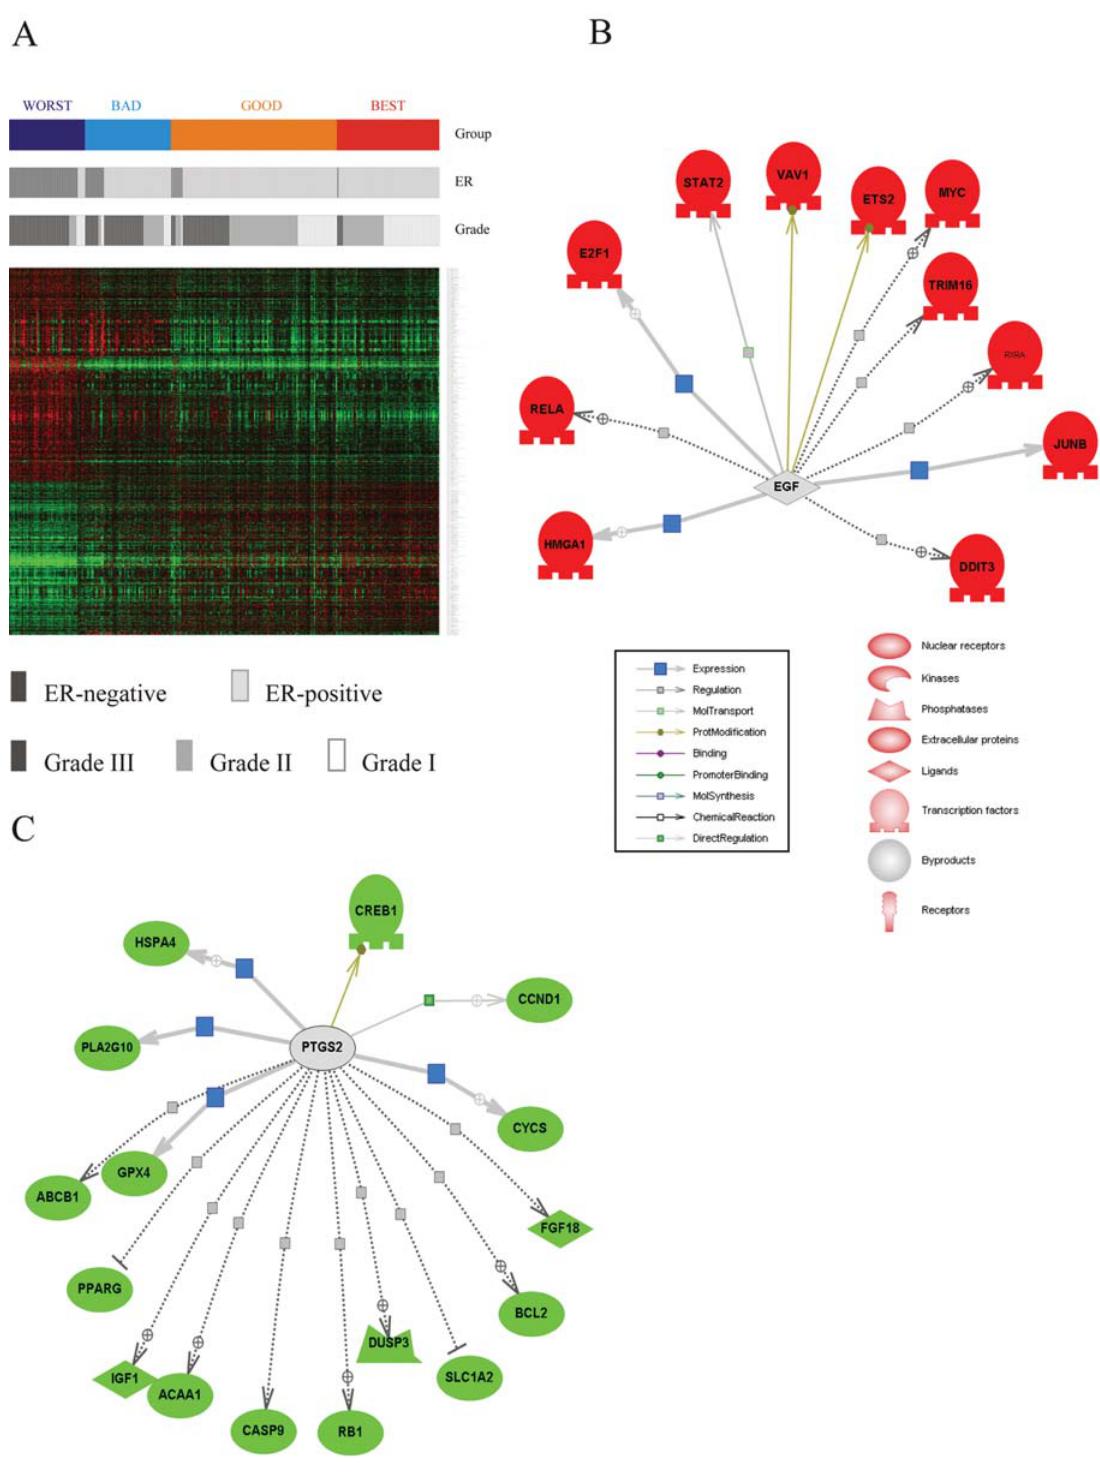
Figure 8. Genes showing significant differences in expression among independent groups (BEST, GOOD, BAD and WORST) A. Gene clustering of 295 NKI samples using genes selected by one-way ANOVA class comparisons. A total of 3307 genes that showed significant expression differences (p , 1 6 10 2 8 ) in a one-way ANOVA analysis were selected. ER expression status and the histo-pathological grade of each tumor sample are shown in grey-scale bars beneath the colored BEST – WORST classification bar. The key to the grey-scale designations is found beneath the heat map. B. PathwayAssist TM –generated figure showing networks of transcription factors activated by EGF and showing significantly higher expression in tumors from patients in the WORST prognosis group (indicated by red color) compared to the BEST prognosis group. C. PathwayAssist TM –generated figure showing networks of genes activated by PTGS2 (COX2) and showing significantly lower expression in tumors from patients in the WORST prognosis group (indicated by green color) compared to the BEST prognosis group.